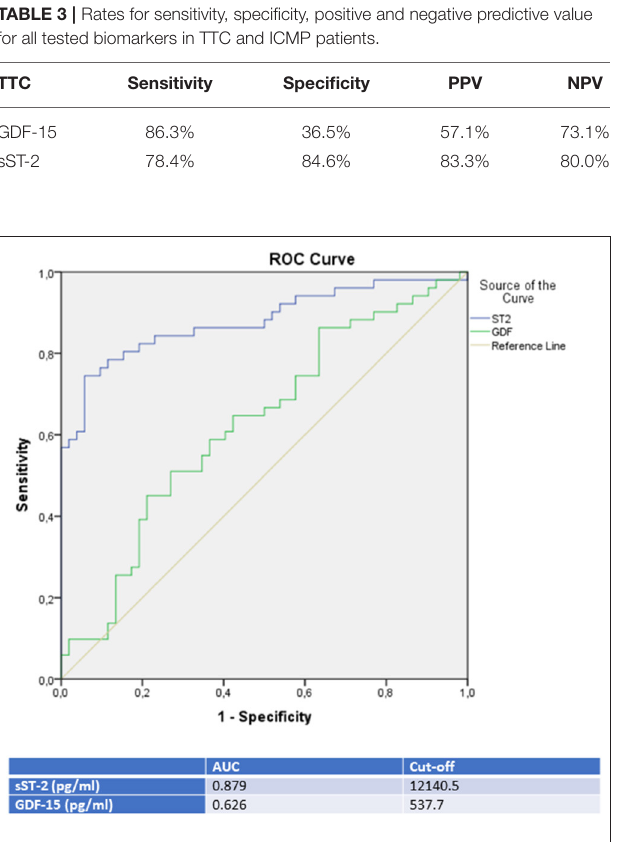
FIGURE 2 | ROC-Curves and cut off scores for sST-2 (ST2) and GDF-15 (GDF) prediction of TTC in the total cohort (including patients with TTC and ICMP).